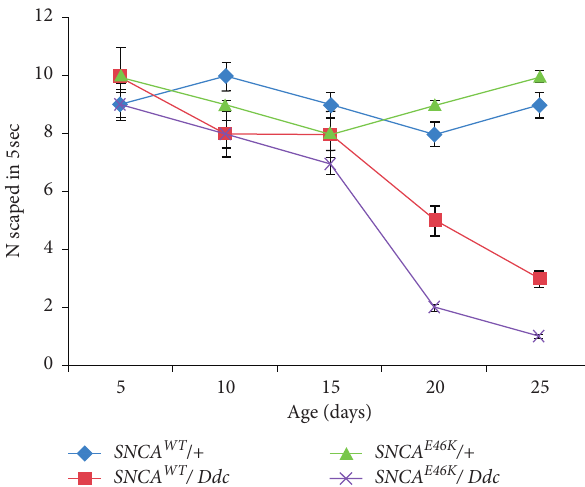
Figure 6: Decreased climbing ability of E46K α -synuclein transgenic flies in a negative geotaxis assay. Dopaminergic neuronal expression of SNCA E46K in the brain of transgenic flies was driven by the promoter Ddc-Gal4 . The descendants showed age-dependent defects in their climbing ability compared to the control genotype. Six replicates of each genotype were analyzed. The average number of flies crossing the 8cm mark in 10 seconds is significantly decreased in 20-day-old and 25-day-old E46K α -synuclein expressing flies ( p < 0 . 01; by one-way ANOVA; n � 24).